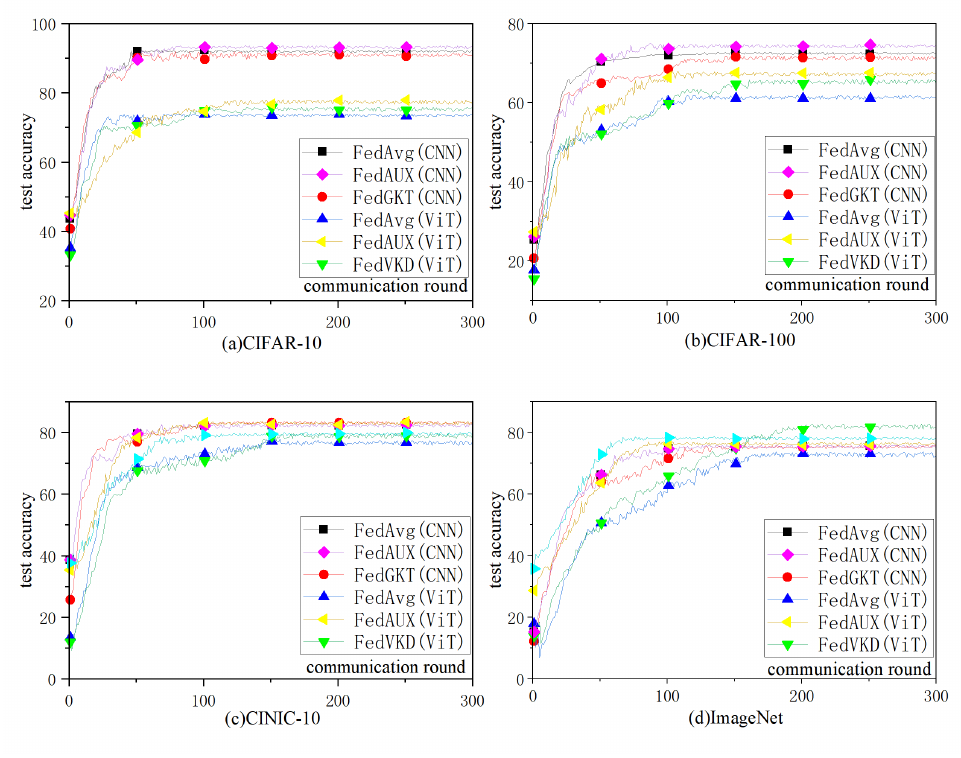
Figure 4. Test accuracy curves of the four frameworks in the four datasets of CIFAR-10, CIFAR-100, CINIC-10, ImagrNet.